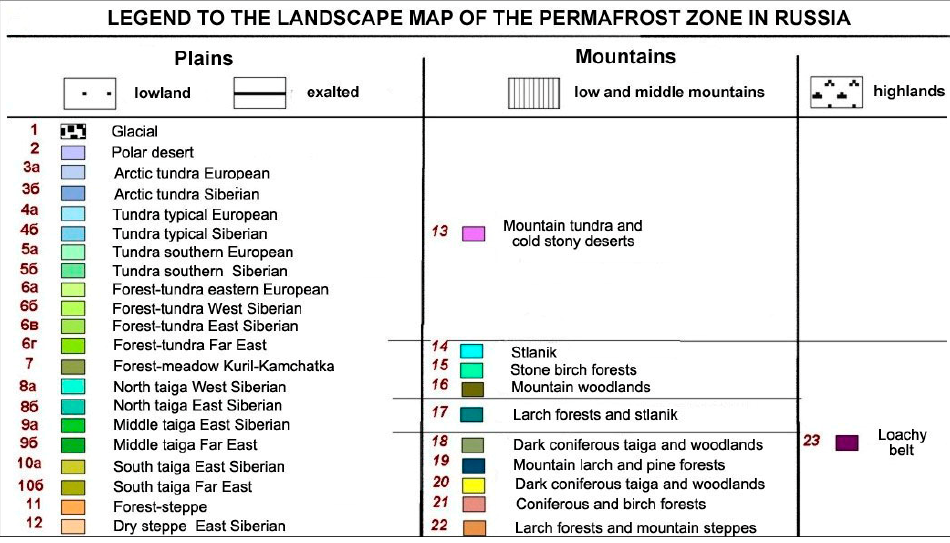
Figure 7. Map fragment the permafrost of Russia, scale 1:20,000,000. Within each type, the territories with different annual mean permafrost temperature are defined within the distribution area. The temperature on plains and plateaus increases from north to south. In mountainous landscapes, the temperatures are lower than on the adjacent plains. The greatest variety in temperature is in the continuous permafrost zone, ranging from –11 °C to –3 °C. In the discontinuous permafrost zone, it is difficult to differentiate the permafrost temperature within the map scale. This type of permafrost is most widespread in mountains and the uplands in